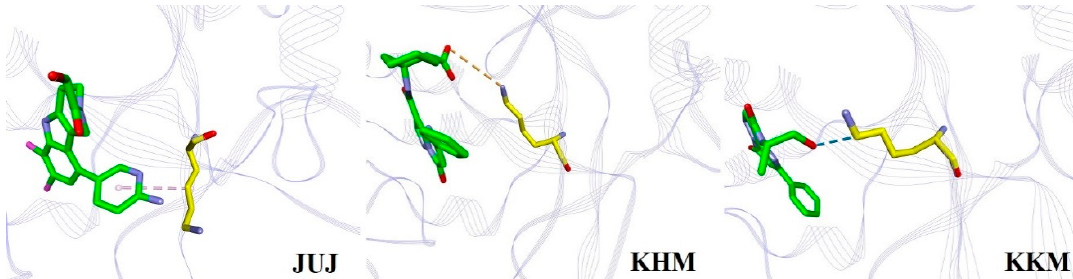
Figure 4. Binding of three inhibitors, JUJ, KHM, and KKM, with K362. The C atoms of inhibitors and residues are shown in green and yellow, respectively. The N, O, and Cl atoms are shown as blue, red, and magenta, respectively. All the hydrogen atoms are hidden for clarity. The proteins are displayed as purple line ribbon. The light pink, orange, and blue dashes represent the C ‒ H· · · π , salt bridge, and H-bonded interactions, respectively.